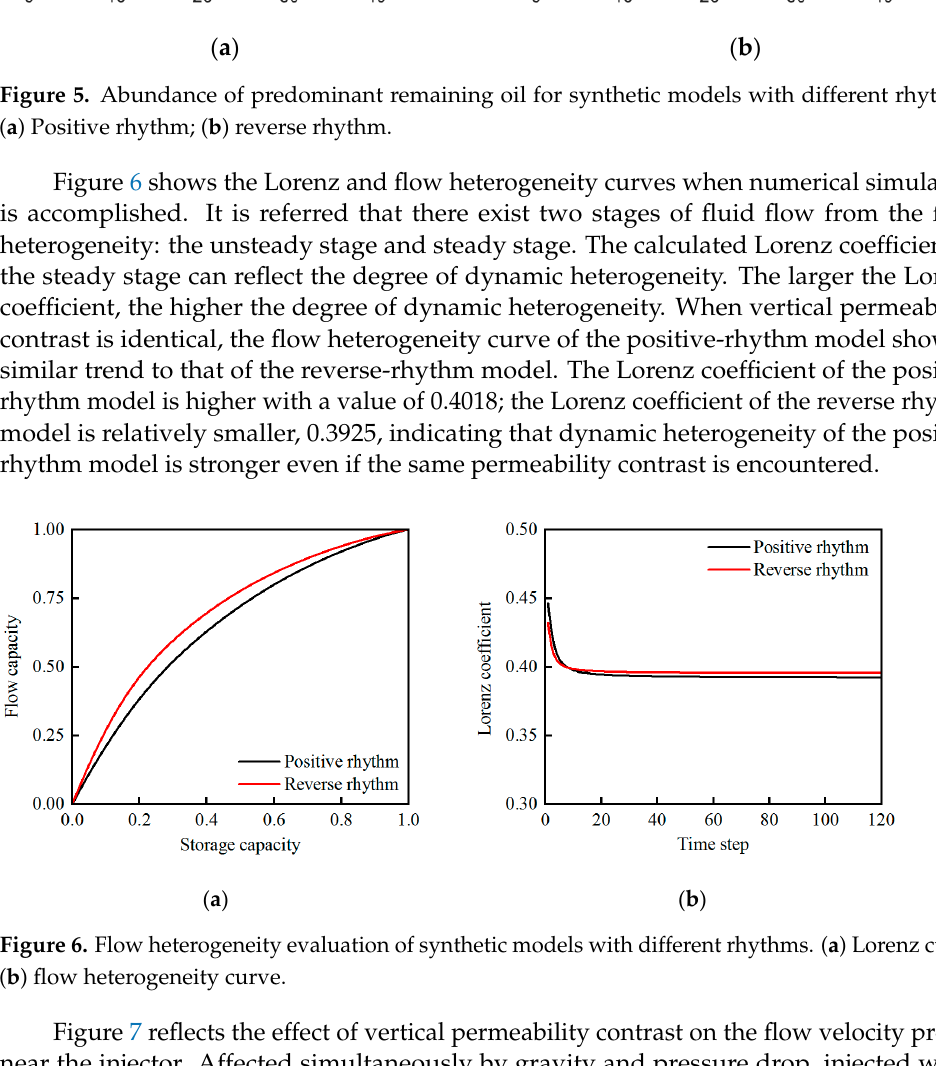
Figure 5. Abundance of predominant remaining oil for synthetic models with different rhythms. ( a ) Positive rhythm; ( b ) reverse rhythm.